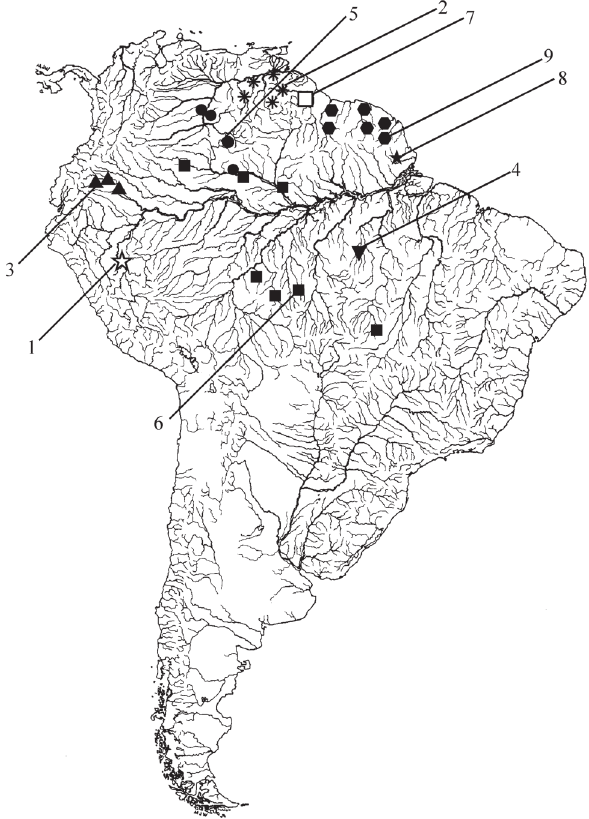
Figura 3. Distribuição de Phenacogaster capitulatus (estrela bran- ca, 1), P. maculoblongus (asterisco, 2), P. napoatilis (triângulo, 3), P. ojitatus (triângulo invertido, 4), P. prolatus (ponto, 5), P. retropinnus (quadrado preto, 6), P. simulatus (quadrado branco, 7), P. wayampi (estrela, 8) e P. wayana (hexágono, 9). Números indicam as loca-